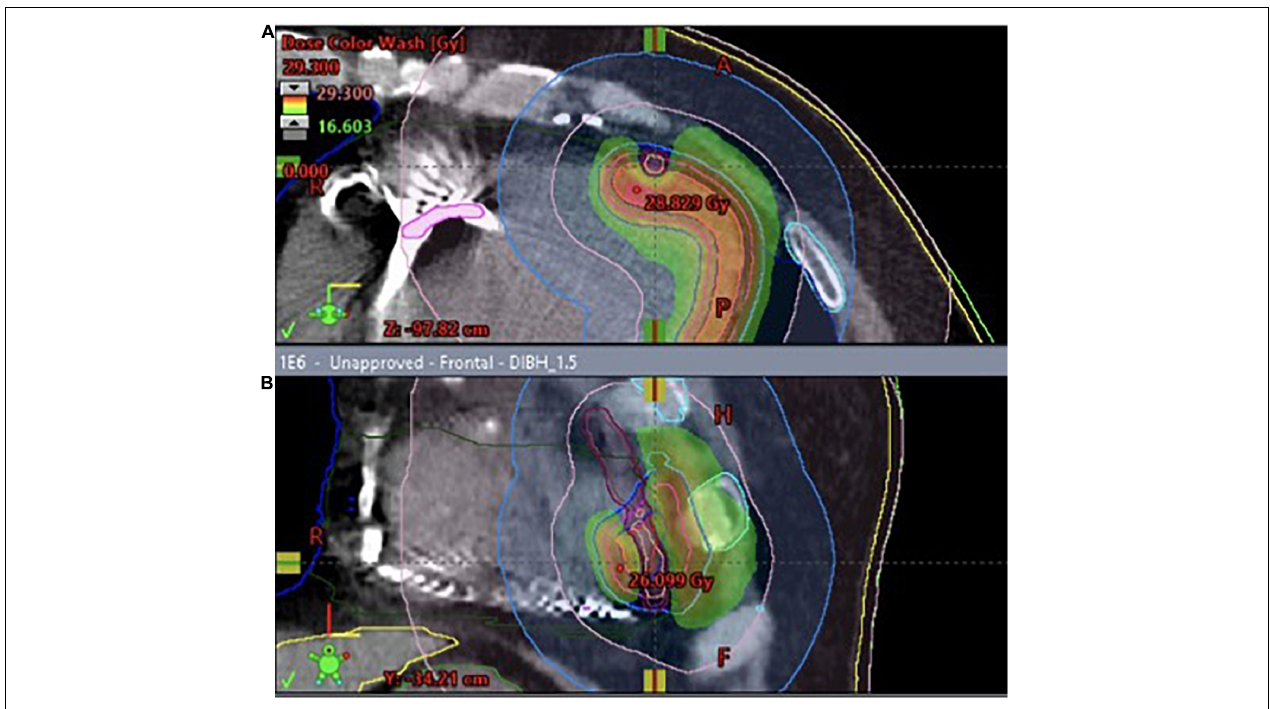
FIGURE 3 | (A) 3D visualization of the treatment plan with three coplanar dynamic arcs (VMAT technique), spatial reconstruction of contoured structures and DRRs (Digitally Reconstructed Radiograms) used for preliminary positioning of the patient. The final adjustment was performed using cone-beam CT (CBCT) superimposed on the planning CT. (B) The dose distribution was optimized to cover the planning target volume while accounting for organs-at-risk such as coronary arteries. Red and orange color represent higher dose, green-